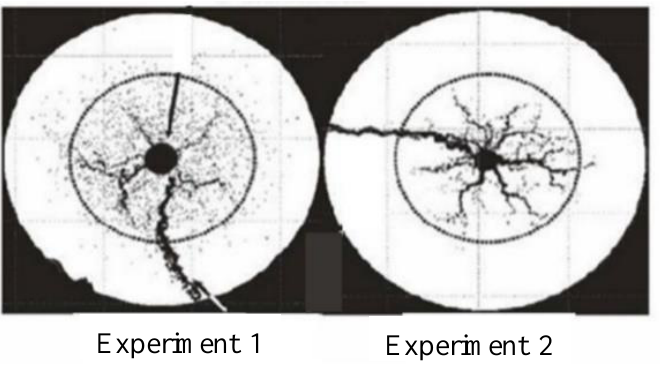
Figure 18. Radial wormhole morphology (adapted with permission from Ref. [27]. 2007, copyright Tardy et al.)